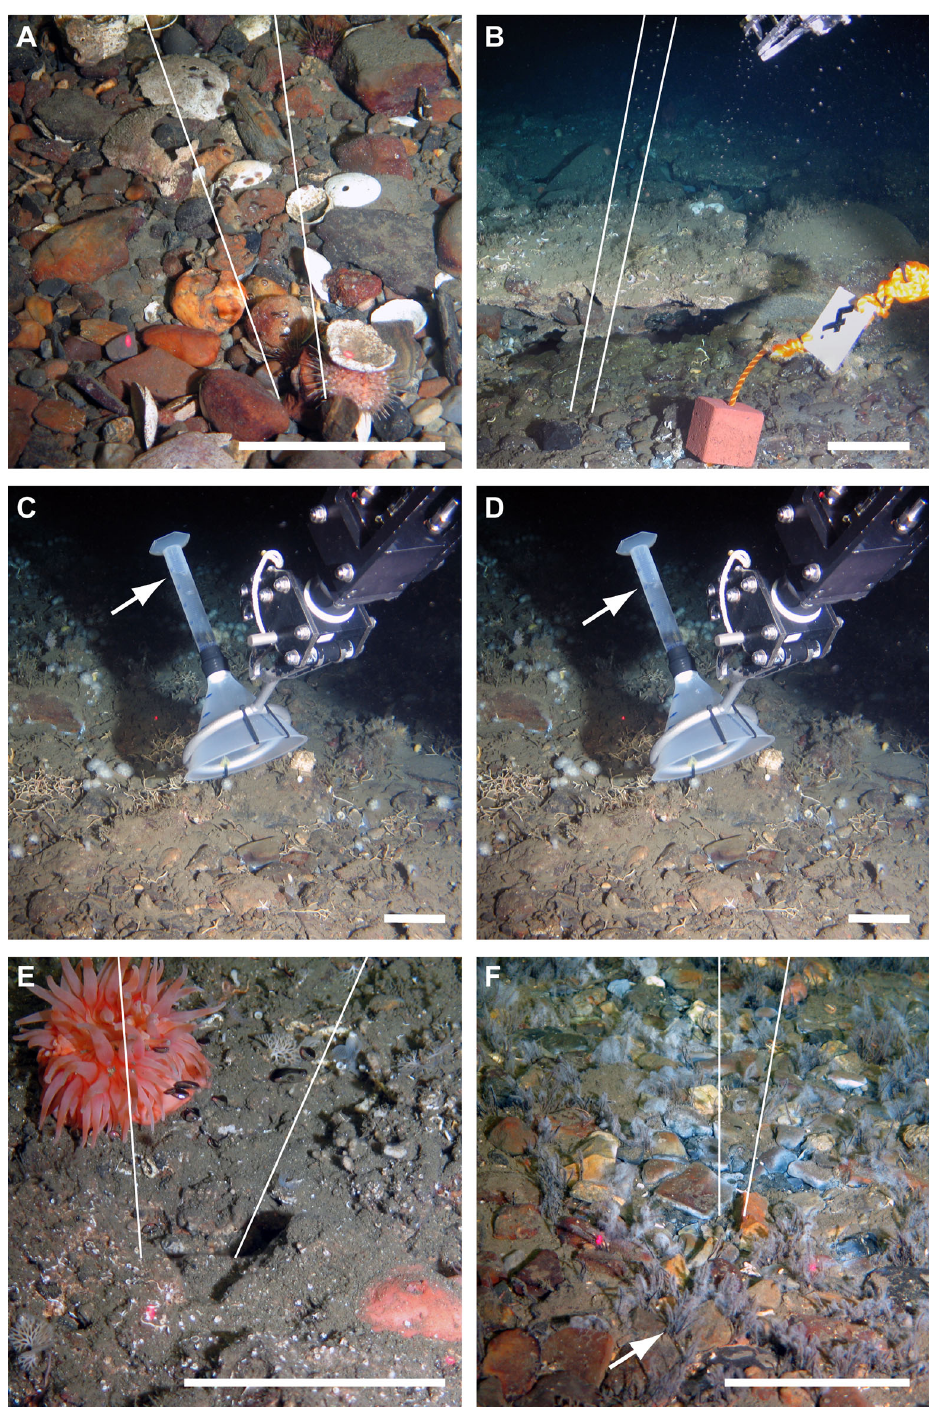
Figure 3. Seafloor images taken during dives with ROV at gas emission sites in Area 1 (a) , Area 2 (b–e) , and Area 3 (f) . Scale bar is 10cm. Arrows point to objects of interest, and white lines outline the trace of the rising bubbles. (a) Bubbles escaping from the cobble-covered seafloor (Dive 02). (b) Three bubble streams at Marker 4. Crusts resemble authigenic carbonates at the seafloor (Dive 04). (c, d) Images illustrating the use of the bubble catcher for measuring the gas bubble volume flux (Dive 05). (e) Bubbles rising in front of an anemone (Dive 04). (f) Filamentous (probably sulfur-oxidizing) bacteria and pogonophora at a bubble stream (Dive 08). Photos courtesy of